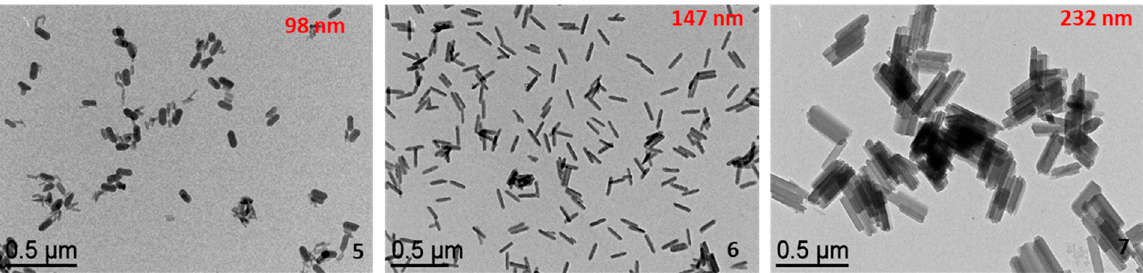
Figure 2. TEM images of the [Fe(Htrz) 2 (trz)](BF 4 )@SiO 2 nanoparticles obtained at various temperature = 273 K (5), 303 K (6) and 333 K (7) for 1 eq of TEOS added in the organic phase (synthetic route A).